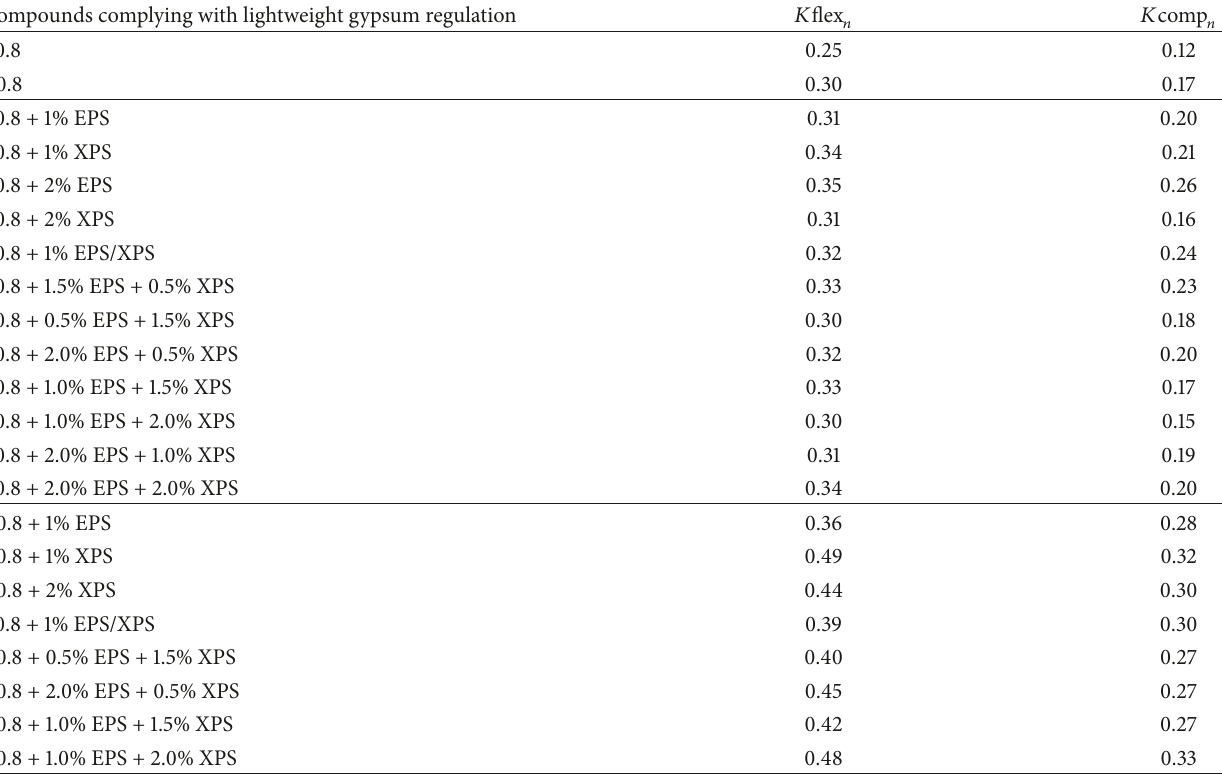
Table 2: Lightening coefficients of selected lightened gypsums.